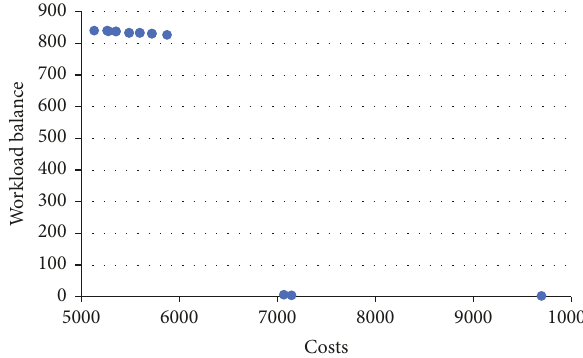
Figure 2: Approximation of the Pareto front of Instance 1.